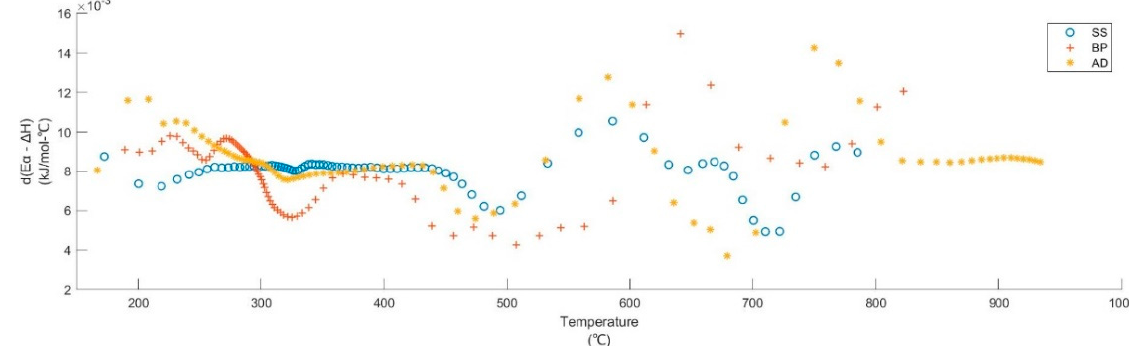
Figure 7. Rate of change of potential barrier during pyrolysis of BP, SS, and AD. Table 3. Thermal regions during the slow pyrolysis of BP, SS, and AD between 25 and 1000 ◦